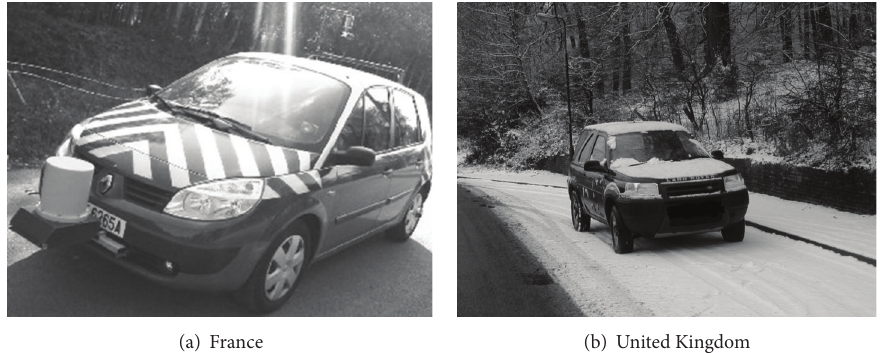
Figure 2: Thermal mapping vehicles in France (a) and United Kingdom